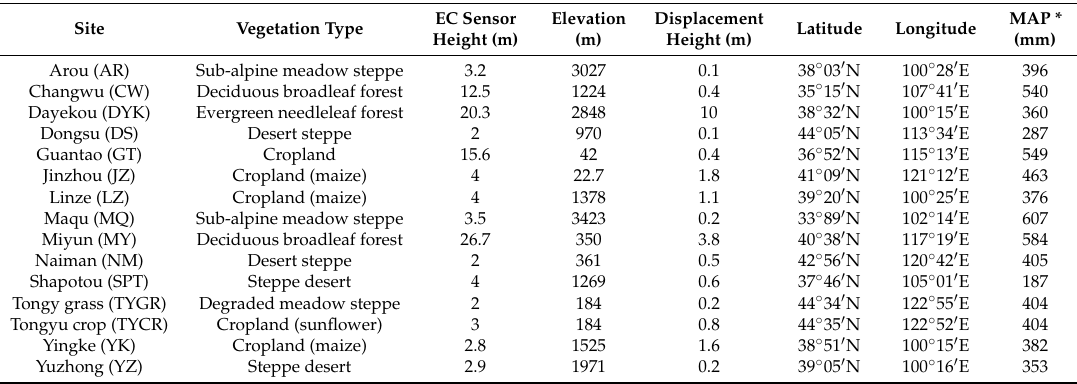
Table 1. Main characteristics of the 15 flux sites in the study region.